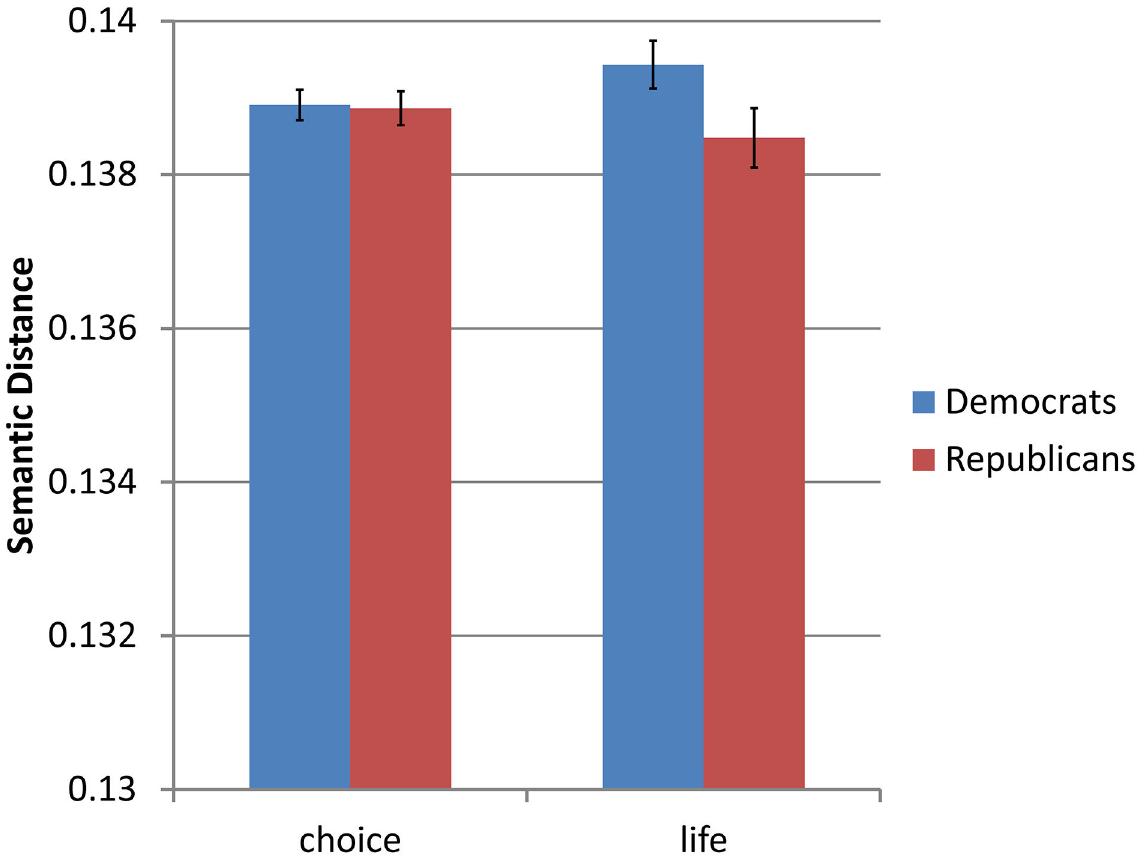
Figure 5. Mean context vector distances of choice and life from abortion by the speaker’s party affiliation. As the zero point of the graph represents identical uses for the term in question and abortion, lower positions in the graph represent greater relevance for the term as a frame of abortion . Error bars represent standard